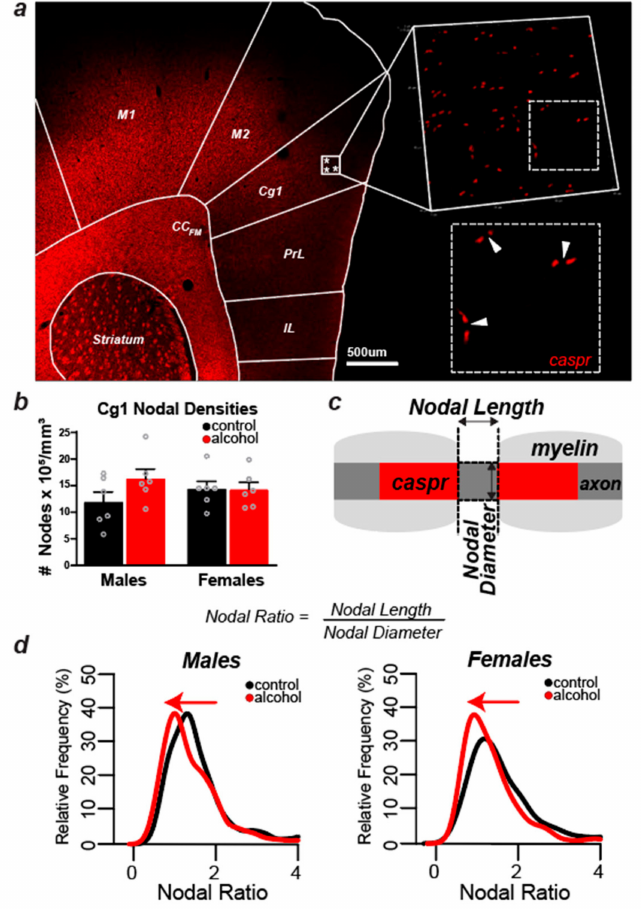
Figure 3. Nodal Densities and Microstructural Analyses. ( a ) Coronal slice (10 × —stitched image) immunolabeled with contactin-associated protein (Caspr) (in red) to show where samples were taken in layer II / III of the medial prefrontal cortex for nodal analyses. ( b ) No significant changes detected in nodal counts in the medial prefrontal cortex of males and females, although there was a small trend for nodal counts to increase with alcohol consumption in males. ( c ) Schematic drawing to demonstrate how nodal ratio measurements were obtained and calculated. The nodal length was defined as the distance between two corresponding Caspr signals, and the nodal diameter was defined as the width of the positive Caspr signal. Nodal lengths and widths were measured to calculate nodal ratios (nodal length / nodal diameter) of nodes in layers II / III of the Cg1 for all 24 animals ( n = 6 / sex / treatment). For each animal, 40 total nodes were measured (average 10 nodes per z-stack from four optical fields of view). ( d ) Alcohol drinking shifted the nodal ratio distribution towards lower ratios in both males and females (two-sample Kolmogorov–Smirnov test, p =